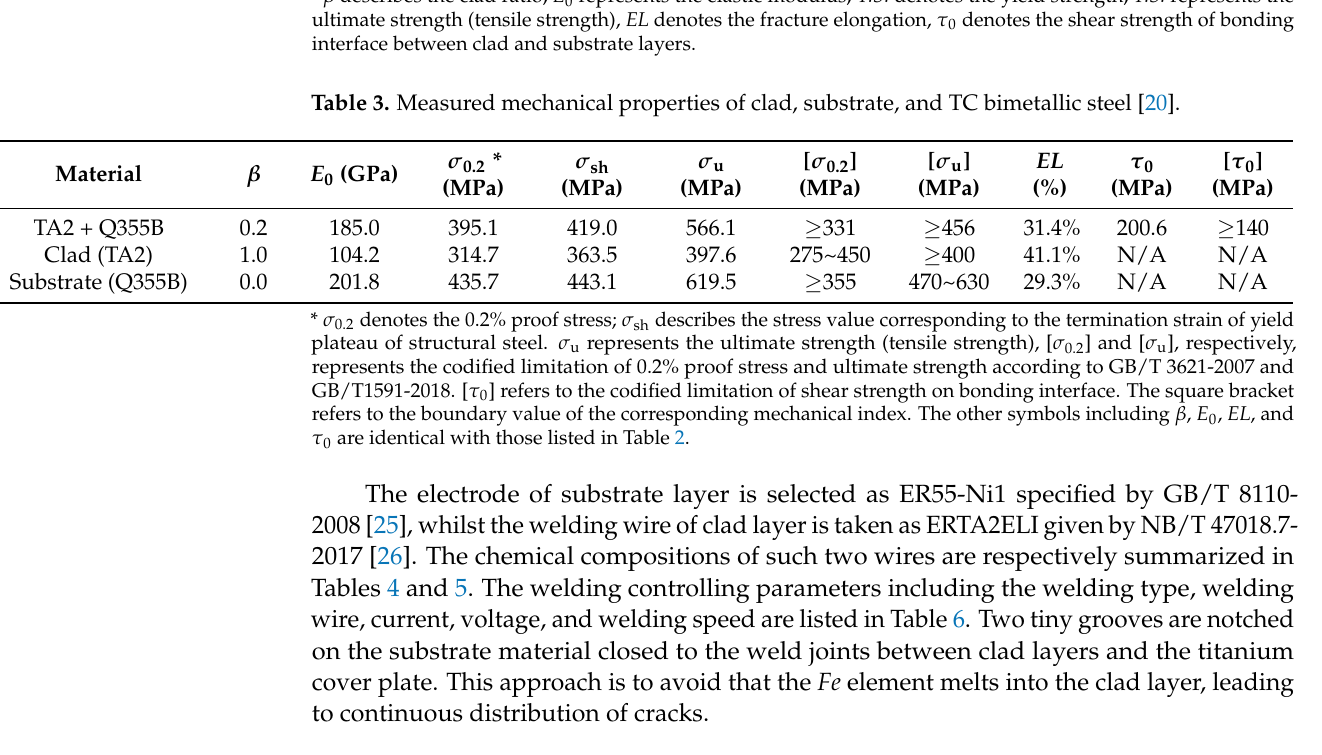
Table 4. Chemical composition of substrate electrode ER55-Ni1